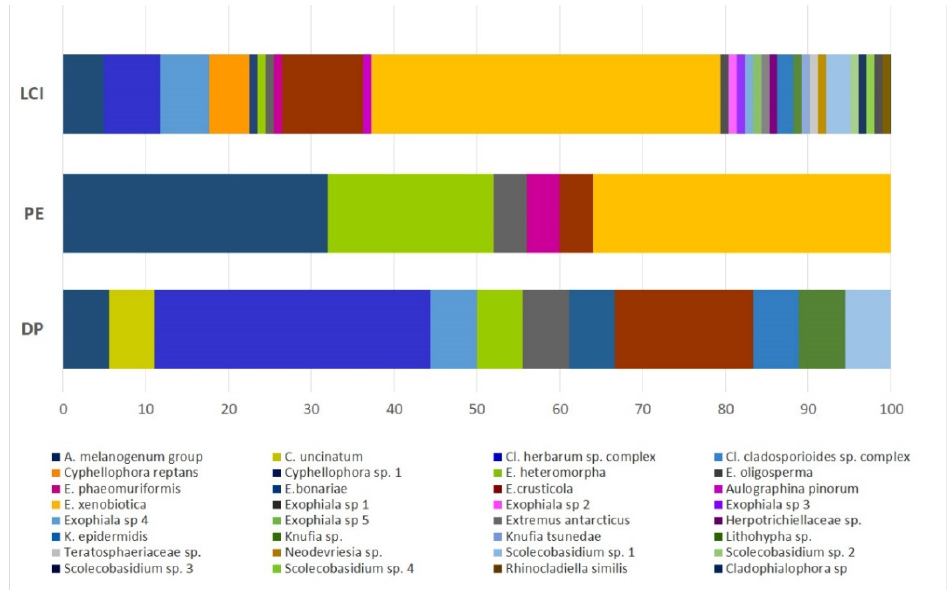
Figure 7. Relative species frequency recorded using the following protocols: long cold incubation (LCI), phenolic enrichment (PE), and direct plating (DP). The species frequency is expressed as percentage (x axis).